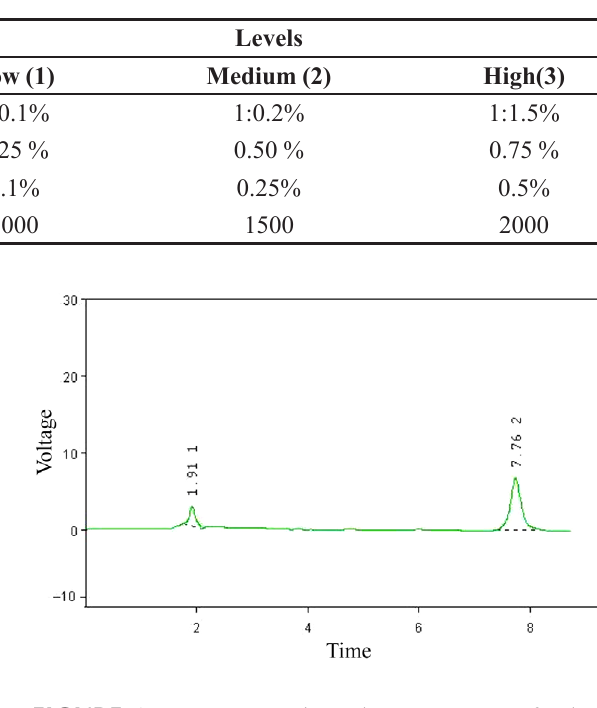
FIGURE 1 - Representative Chromatogram of selegiline hydrochloride (Peak at 7.762